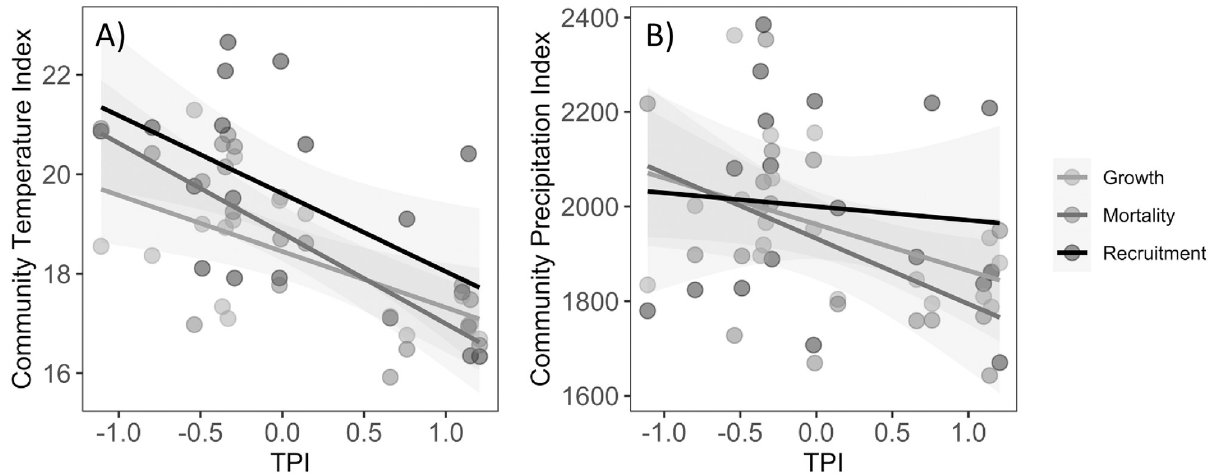
Fig 1. Non-metric dimensional scaling (NMDS) of tree species composition along a topographic gradient measured as Topographic Position Index (TPI). A) Indicates variation in species composition during the first monitoring, B) indicates differences in floristic composition between dead and recruited summarized in a NMDS axis along the topographic gradient. Each point represents a forest monitoring